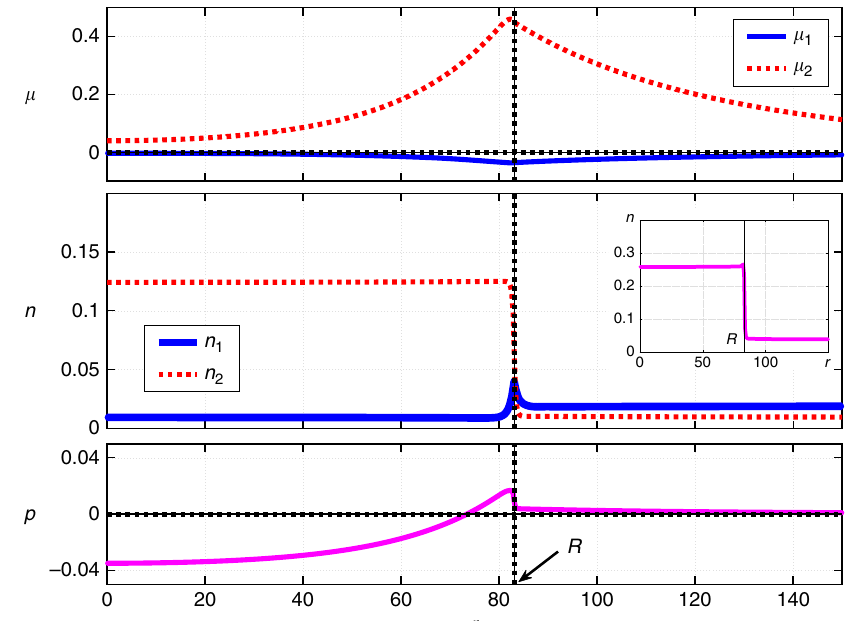
Fig. 3 Stationary droplet solution, 1st order reaction case. The radial-coordinate dependences of the chemical potentials μ i ( i = 1, 2), concentrations n i ( i = 1, 2), and pressure p for a stationary cluster of radius R . The radial-coordinate, r , is measured from the center of the cluster. The inset shows the r - dependence of the total amount of the solute, n ≡ n 1 + 2 n 2 . Δ g = 0.04. The rest of the parameter values are the same as in Fig. 1